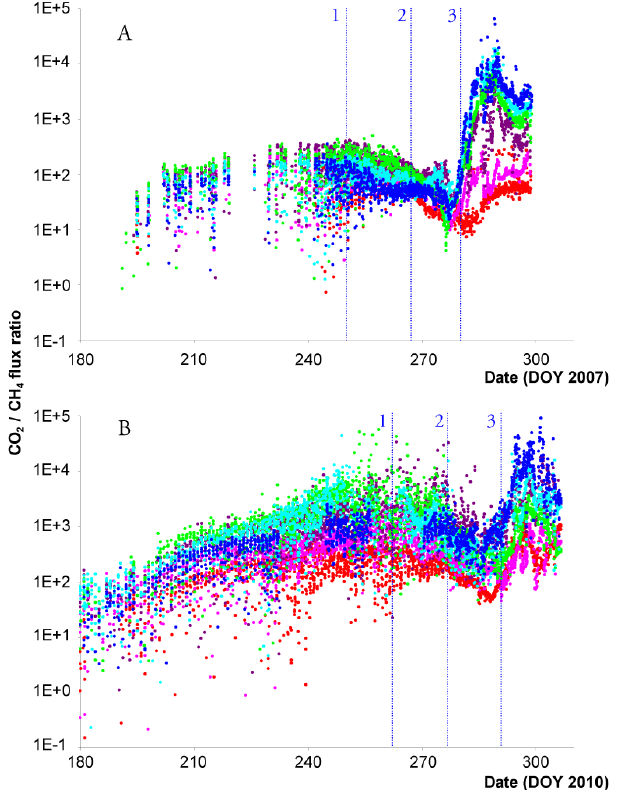
Fig. 8. Example of late-season correspondence between CH 4 and CO 2 fluxes. Six colors correspond to six individual chambers, each dot is CO 2 /CH 4 ratio for one individual measurement. A 2007 data; B 2010 data. 1, 2, 3: time marks (see Table 1); 1: soil temper- ature at 0 ◦ C, bound between the growing season and the freezing season; 2: soil is frozen to 5cm depth; 3: soil is frozen to 15cm depth.